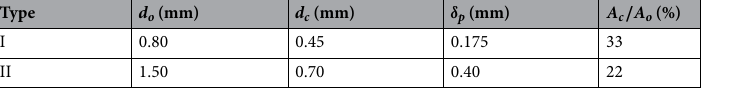
Table 1. Configuration of thin wires: wire diameter ( d o ), inner core diameter ( d c ), insulation thickness ( δ p ), and the cross-section area ratio of core to wire ( A c / A o ).